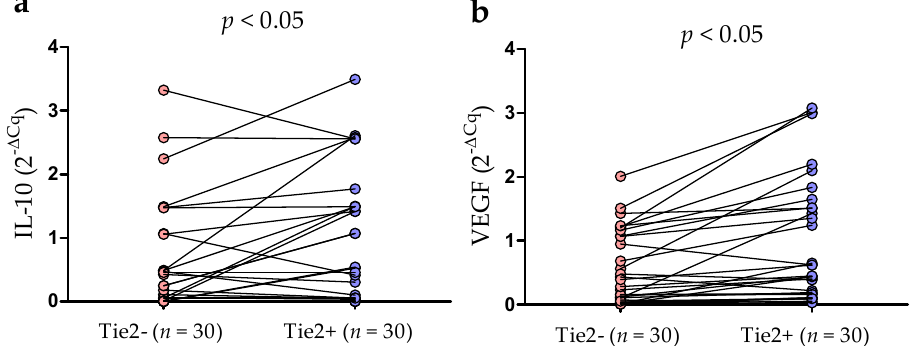
Figure 8. Quantitative expression of IL-10 ( a ) and VEGF ( b ) mRNA. RT-qPCR was performed on RNA samples isolated from Tie2+ (TEM) and Tie2- monocytes obtained from CLL patients ( n = 30). Data are presented as 2 -ΔCq . ΔCq is the difference between the Cq of the target gene (Cqt) and the reference gene (Cqr) (ΔCq = Cqt−Cqr). TEM, Tie-2 expressing monocytes; Cq, cycle quantification value.